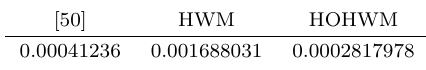
Table 7. Comparison to [50]: maximal relative deviation from the exact solution at J =